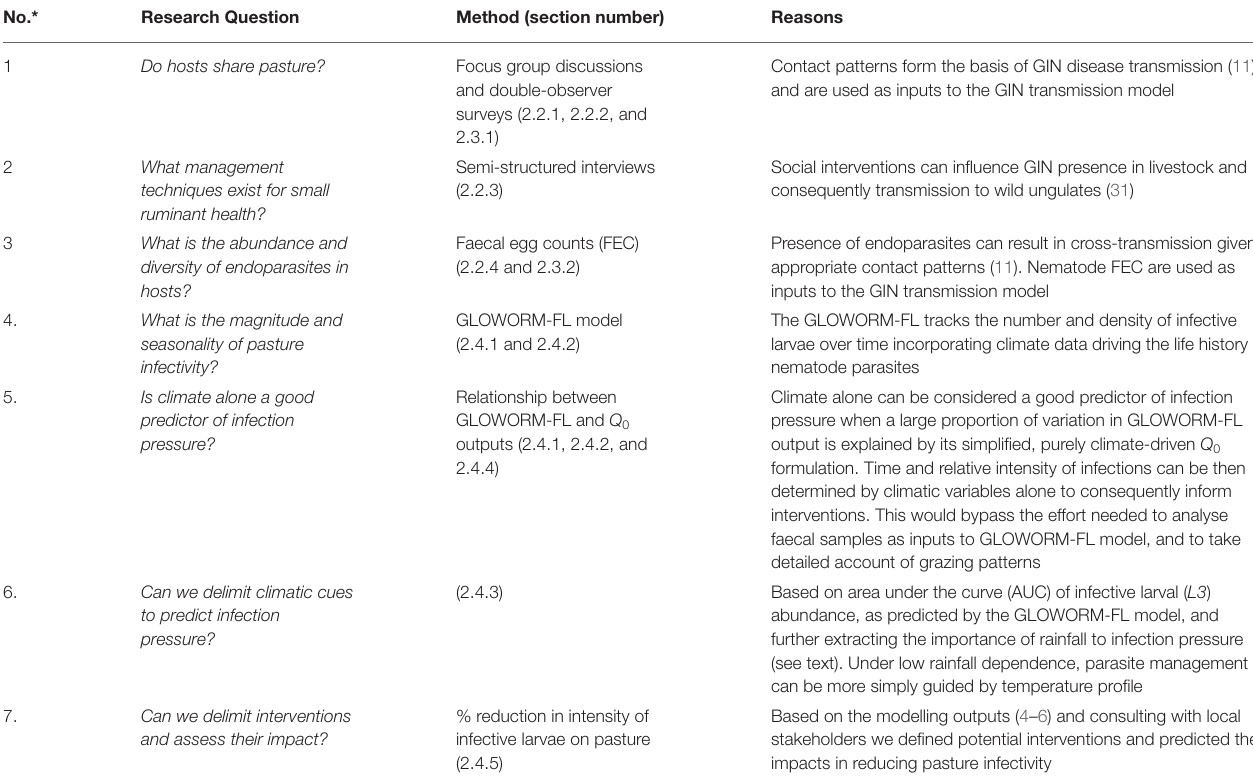
TABLE 1 | Research questions with reasoning and methods used to answer those questions, in order to understand two-host GIN system dynamics and inform measures using Kibber as a case study.